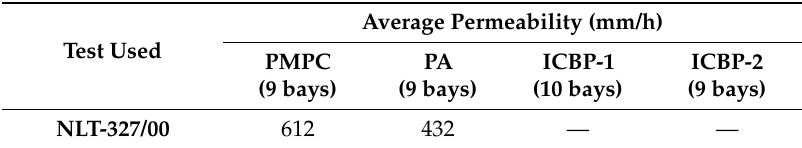
Table 4. Permeability values for the porous-mixture surfaces after eight years of operation.